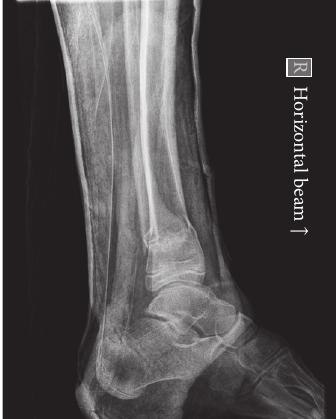
Figure 2: Case one: lateral view of the ankle on admission to the emergency room confirming a tibiofibula transposition.